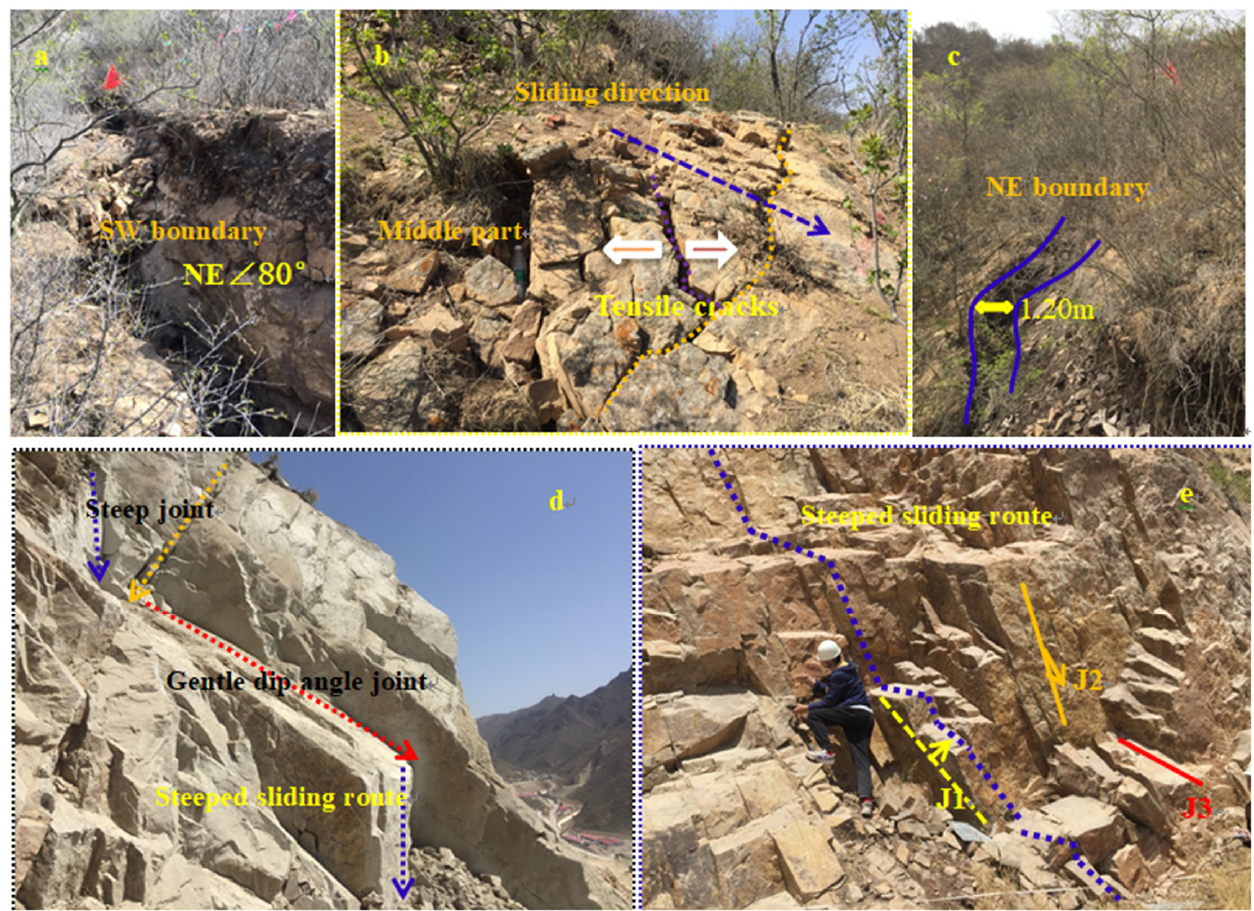
Figure 15. Composition and failure type of sliding failure surfaces (combination of stepped-gentle joints). Combination of stepped-gentle joints of sliding failure surface. ( a ) tension fissure at trailing edge. ( b ) tensile cracks in middle part. ( c ) shear fissure at NE boundary. ( d ) Combination of anti-inclined joint and inclined unloading joint. ( e ) Combination of inclined joint and inclined unloading joint.